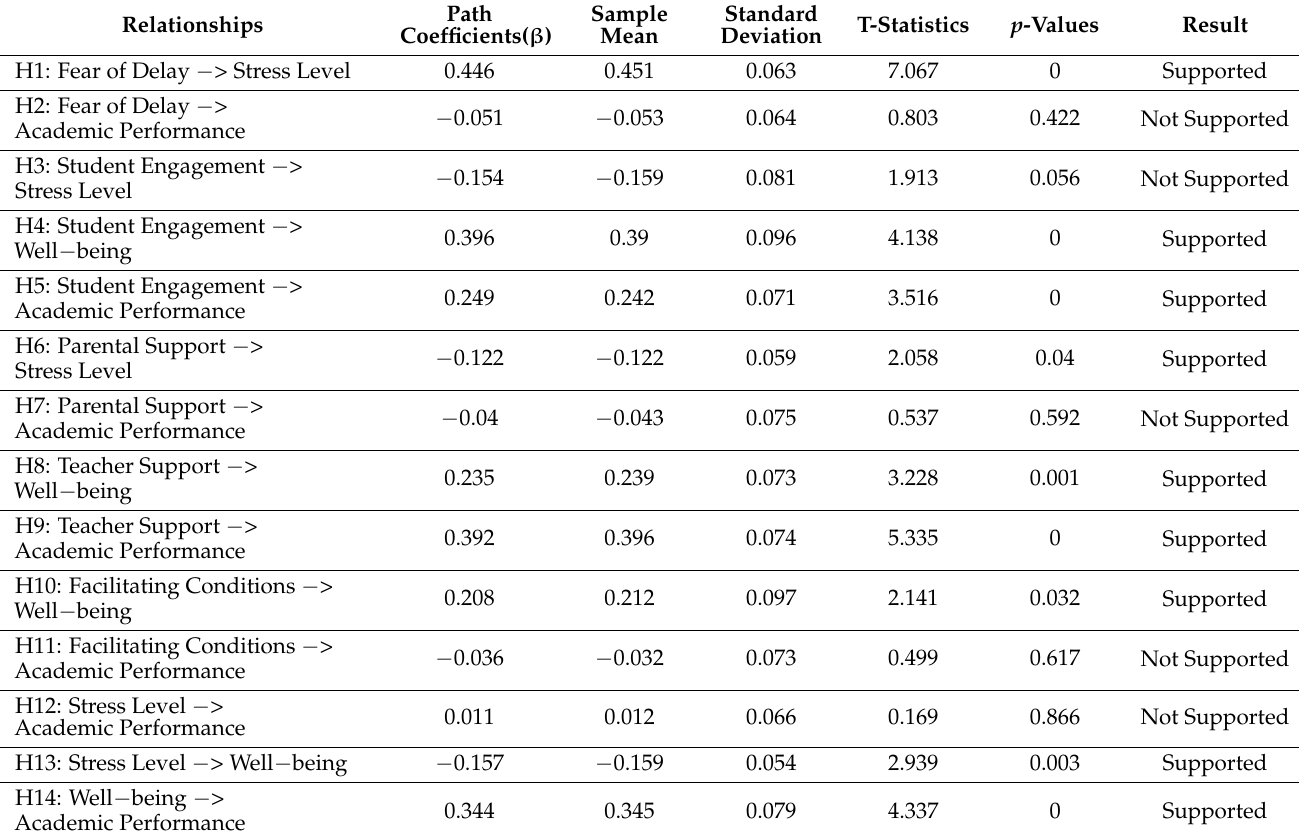
Table 7. Results of the initial hypothesis test.